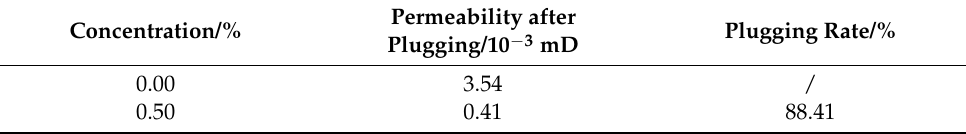
Table 1. Evaluation of plugging effect of poly (MMA-BA-ST) on artificial cores at 105 ◦